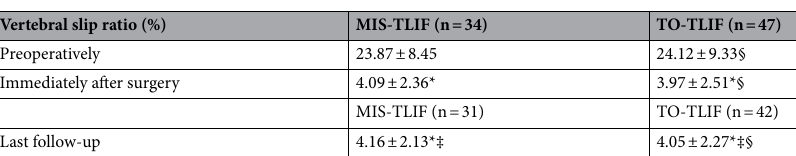
Table 4. Comparation of vertebral slip ratio between the two groups. * P < 0.05, vertebral slip ratio at each time point postoperatively versus preoperative score in each group. ‡ P > 0.05, slip ratio at last follow-up versus immediately after surgery in each group. § P > 0.05, comparation of vertebral slip ratio at each time point between the two